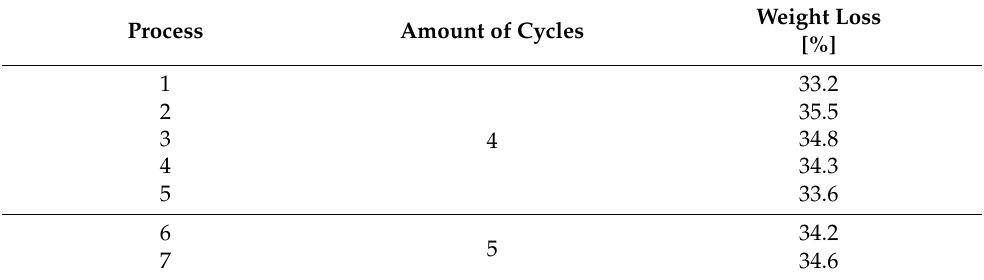
Table 1. Results of removal of waxes from crickets via Soxhlet extraction.